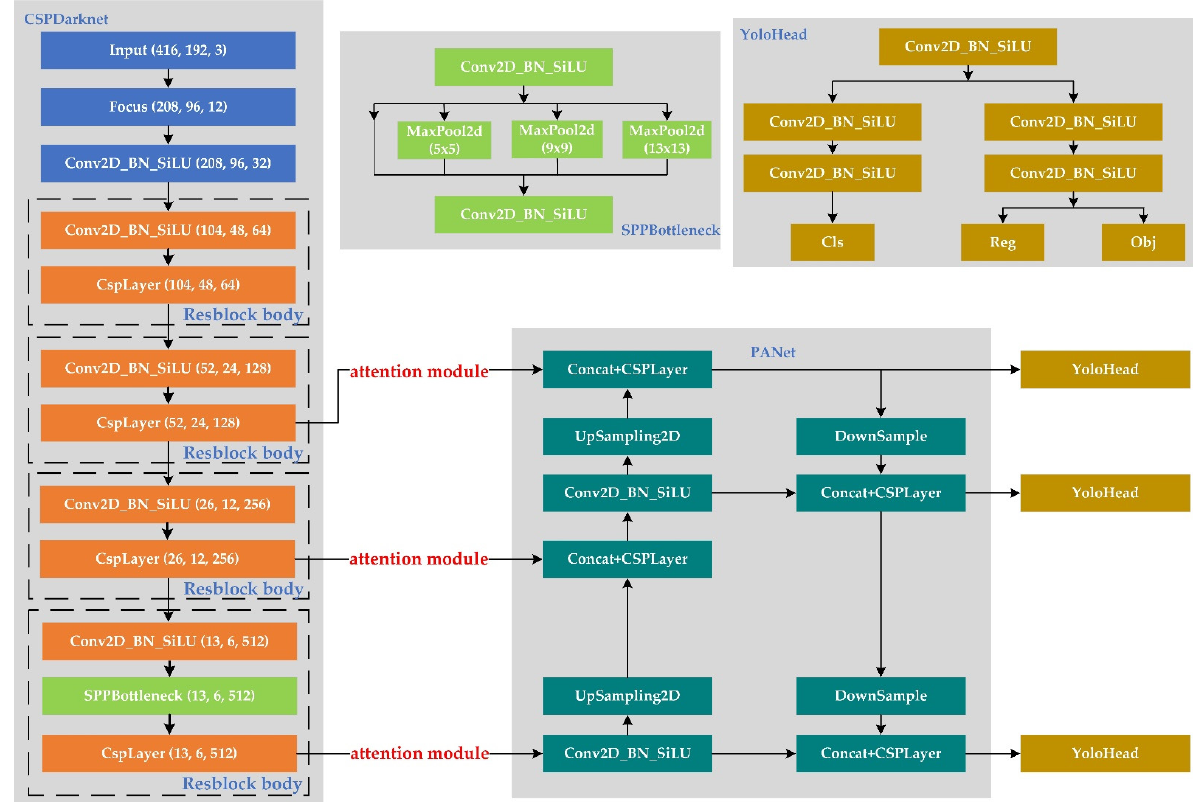
Figure 3. TIPYOLO network structure.